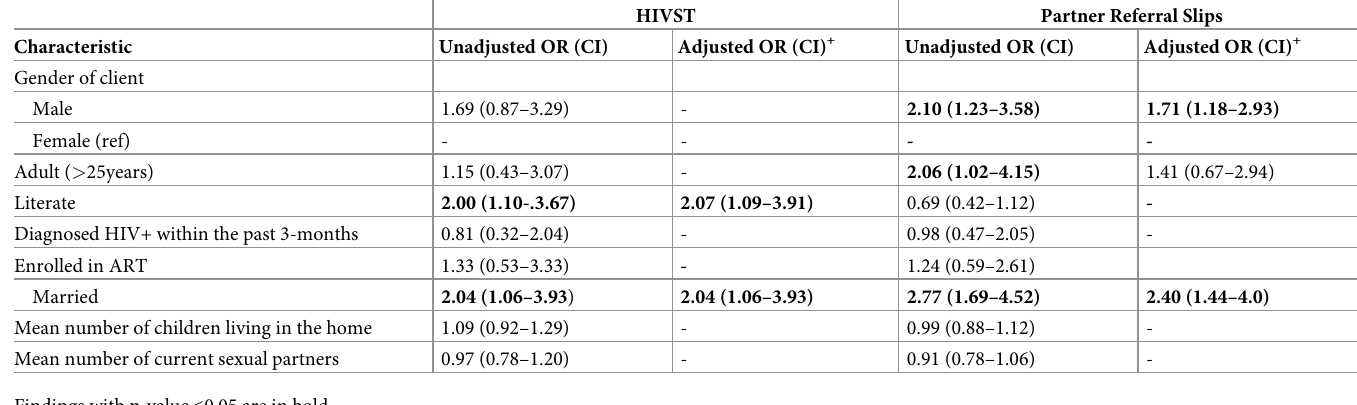
Table 3. Univariate and multivariable regression analysis of predictors of HIV-positive clients reporting being willing to distribute the testing intervention to their sex partner(s) (n =